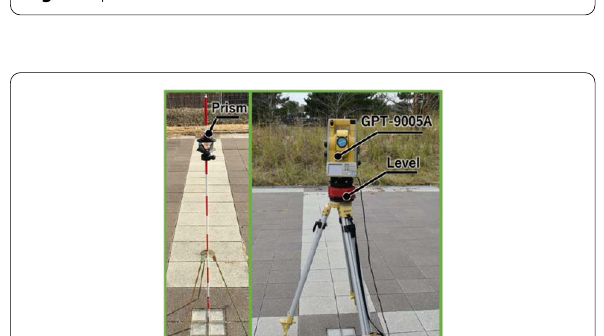
Fig. 9 Experimental conditions